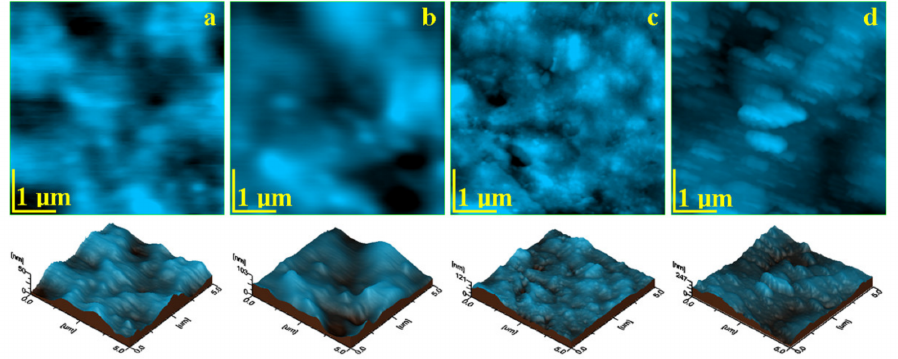
Figure 5. AFM topographic images of the samples surfaces after 60 days of exposure: ( a ) Blugloo, ( b ) Light Bond, ( c ) Opal Seal, and ( d ) Experimental material C1.